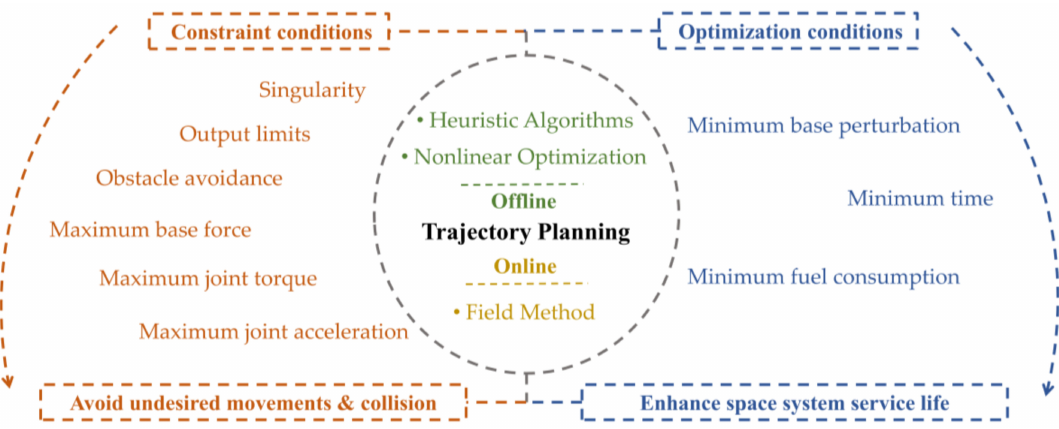
Figure 5. Conditions and methods of trajectory